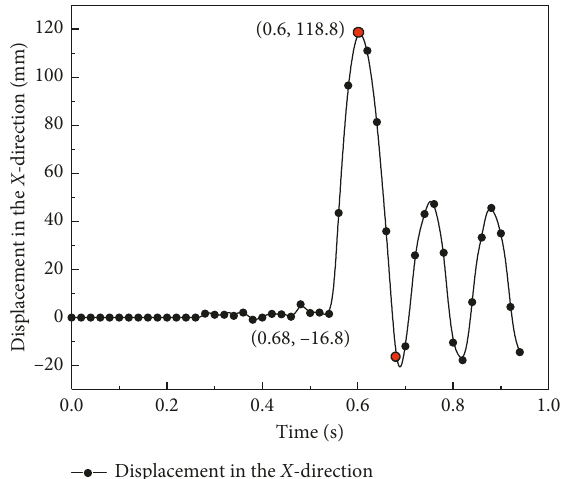
Figure 8: Time-history curve of X -direction displacement at point A.